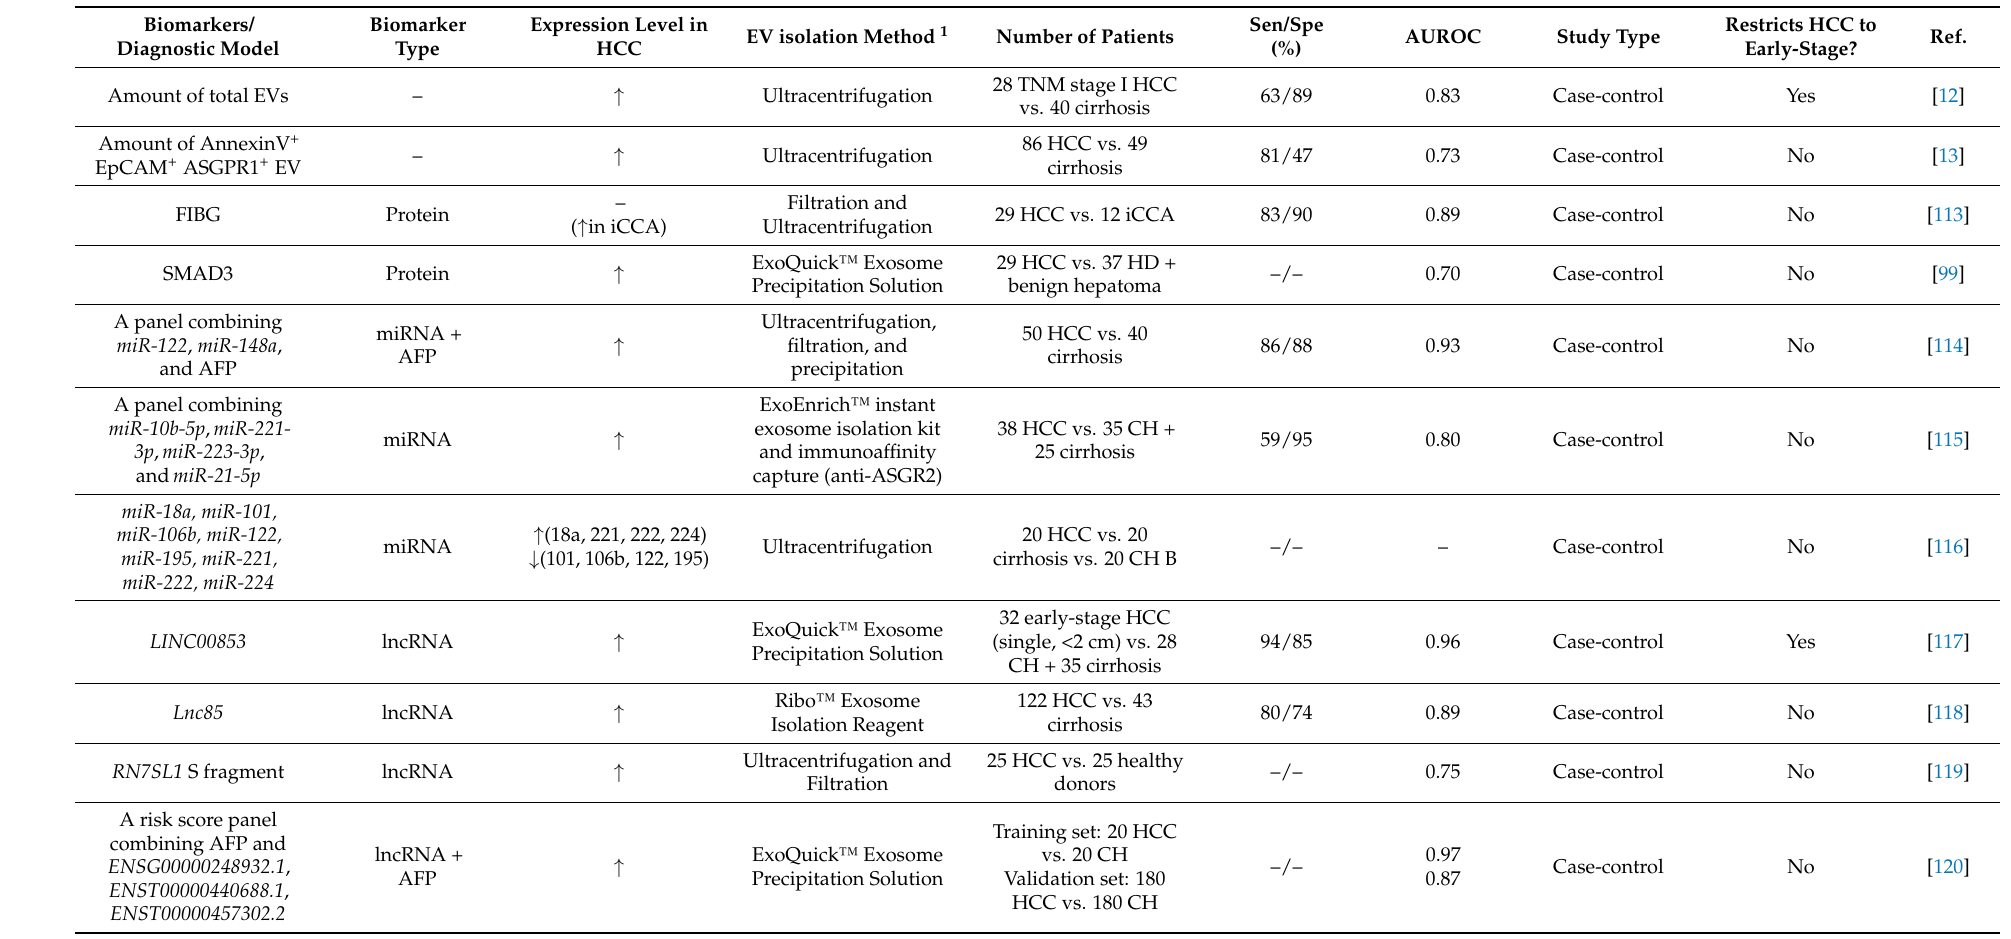
Table 2. EVs as biomarkers for detection of